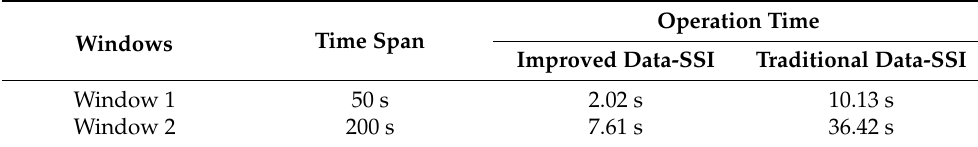
Table 5. Operation time of the improved Data-SSI and the traditional Data-SSI methods.